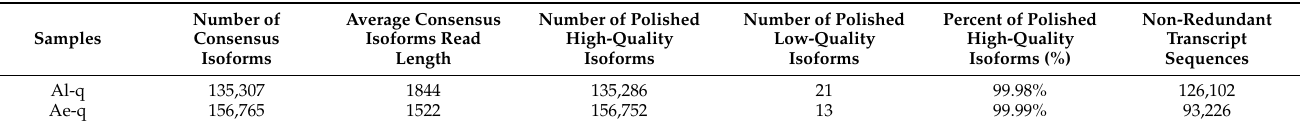
Table 1. Statistical table of three-generation full-length transcriptome clustering of leaves from A. latifolia (Al) and A. eriantha (Ae).